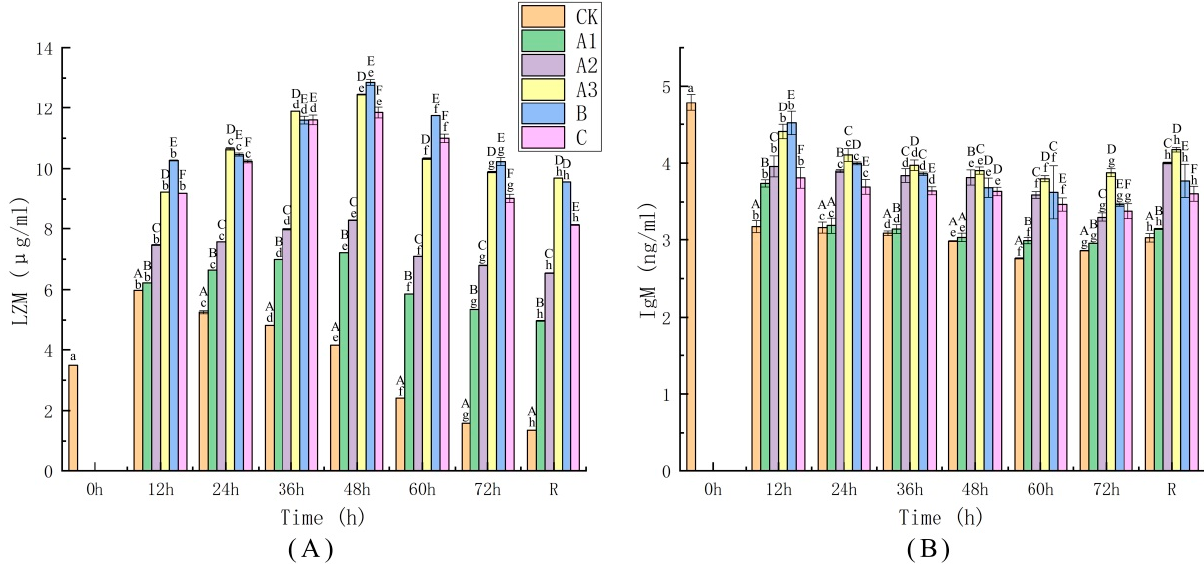
Figure 5. The activity of lysozyme (LZM; ( A )) and concentrations changes of immunoglobulin M (IgM; ( B )). The groups represented by different letters and numbers are the same as in Figure 3.